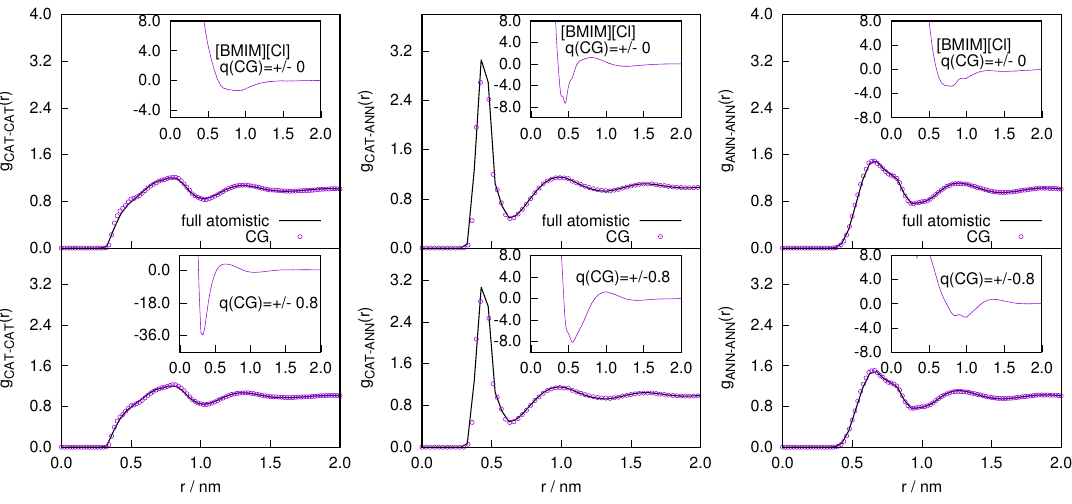
Figure 8. The radial distribution function obtained from reference atomistic and coarse-grained simulation with charged ( bottom ) and neutral model ( top ) as a function of distance r for the [ BMIM ][ Cl ] − . The CG simulation employs the IBI potential, V CG ( r )( kJ / mol − 1 ) for the charged and uncharged CG model (inset).